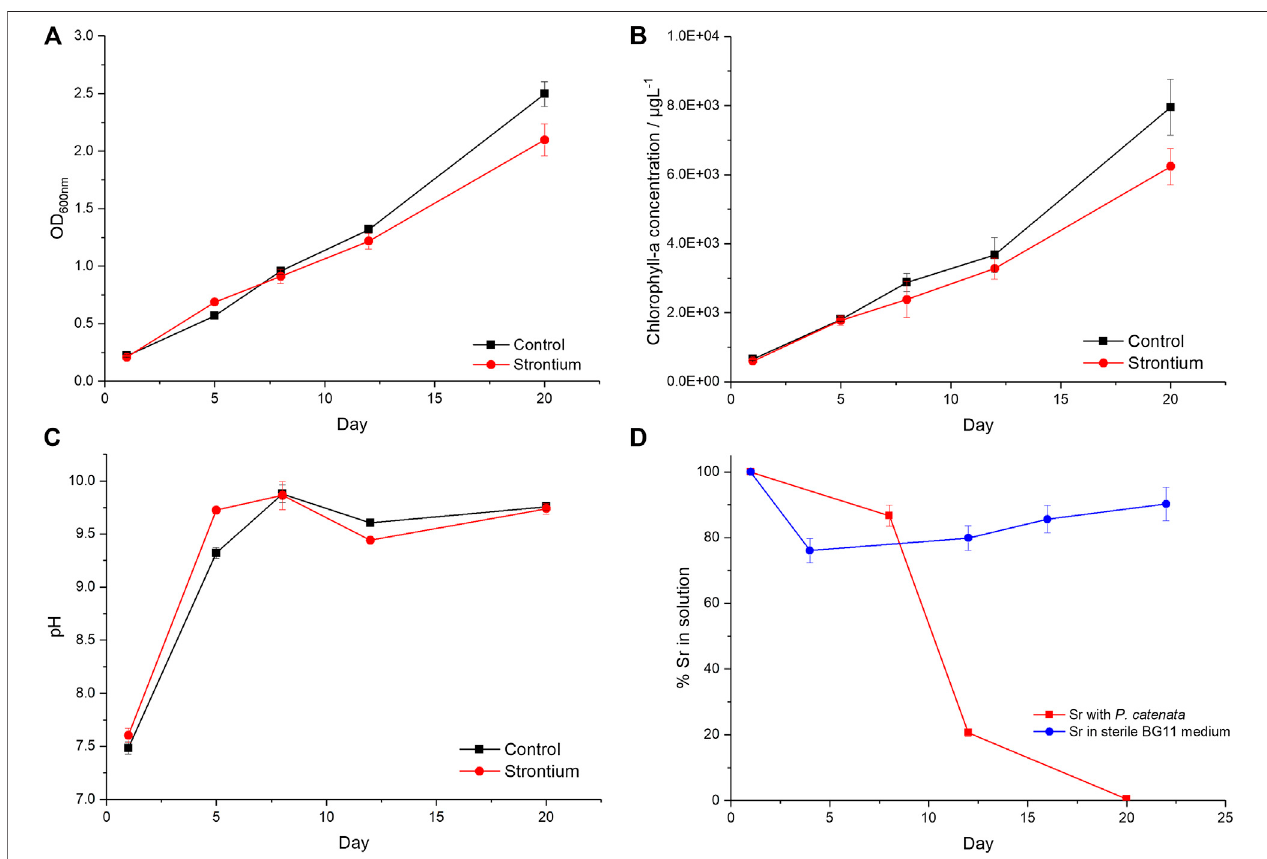
FIGURE 1 | Growth curves of P. catenata with and without the addition of Sr. (A) optical density at 600 nm, (B) Chl-a concentrations ( μ g L − 1 ), (C) pH, and (D) percentage of Sr in solution measured by Inductively Coupled Plasma Atomic Emission Spectroscopy in sterile BG11 medium at pH 7.5 and in the presence of P. catenata where the pH of the medium is shown in panel (C) . Error bars are the standard deviation of three replicates.